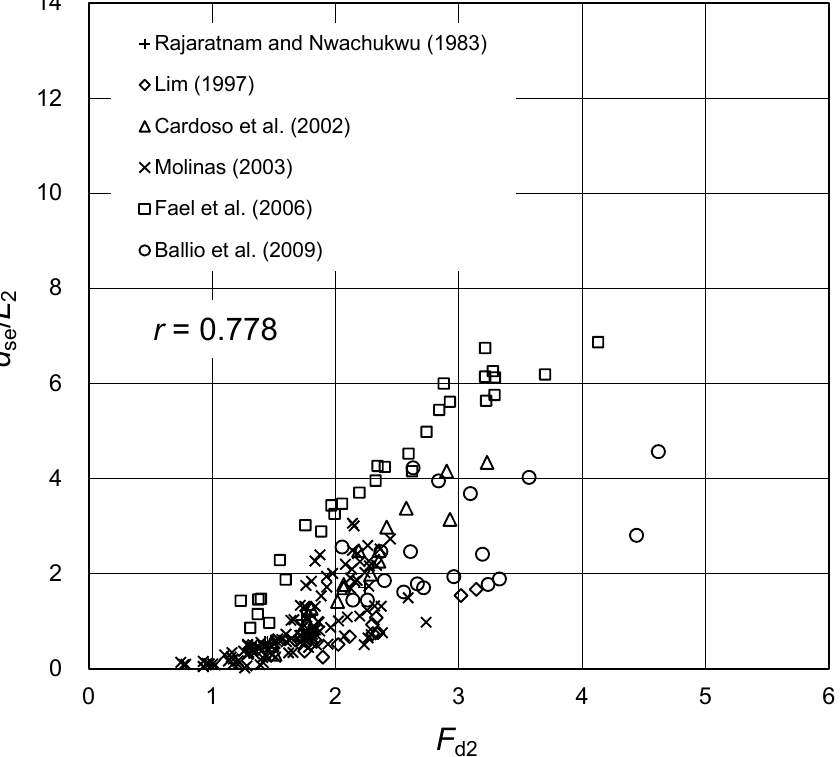
Figure 4. Plot of d se / L 2 against F d 2 ( L 2 = h ). Figure 4. Plot of (cid:1856)